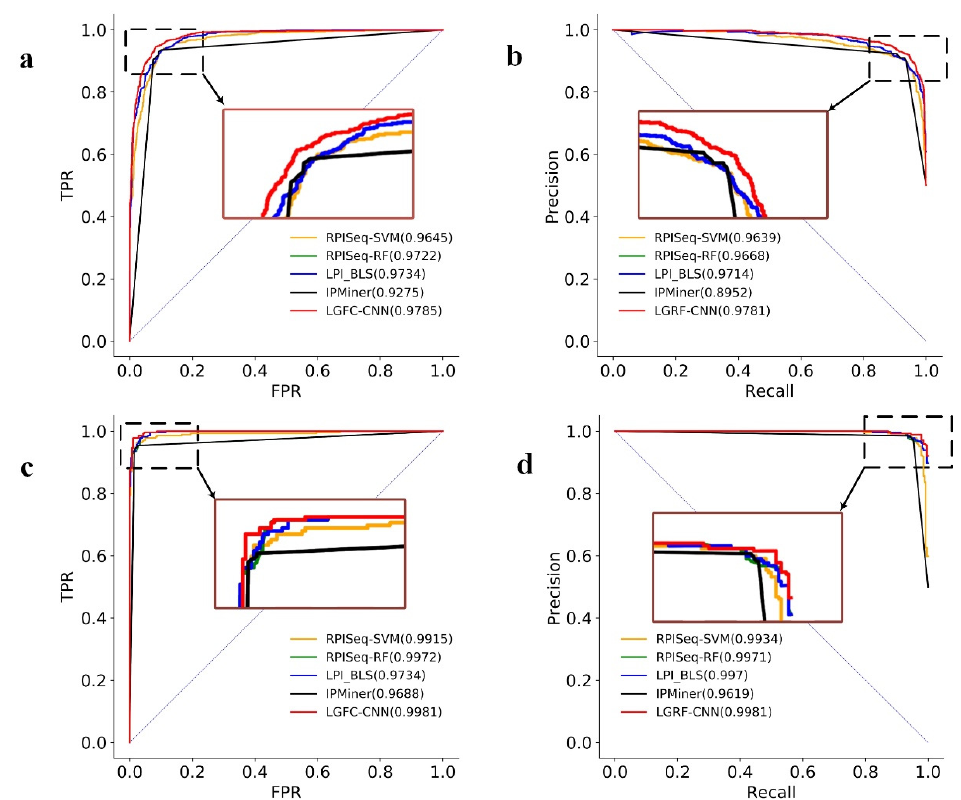
Figure 5. ( a ) The ROC curves and ( b ) the PRC curves of LGFC-CNN and other four methods on RPI7317. ( c ) The ROC curves and ( d ) the PRC curves of LGFC-CNN and other four methods on